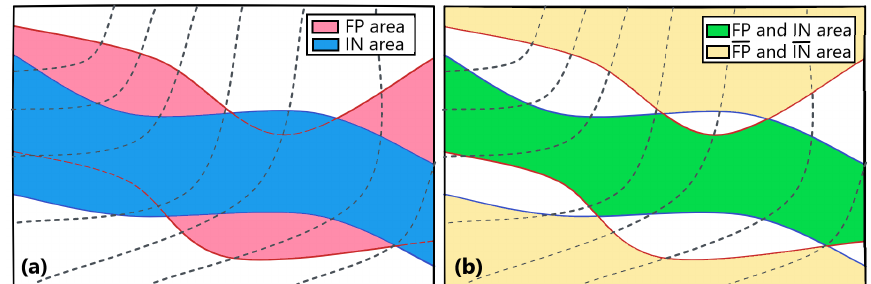
Figure 4. Flood-prone (FP) and inundated (IN)